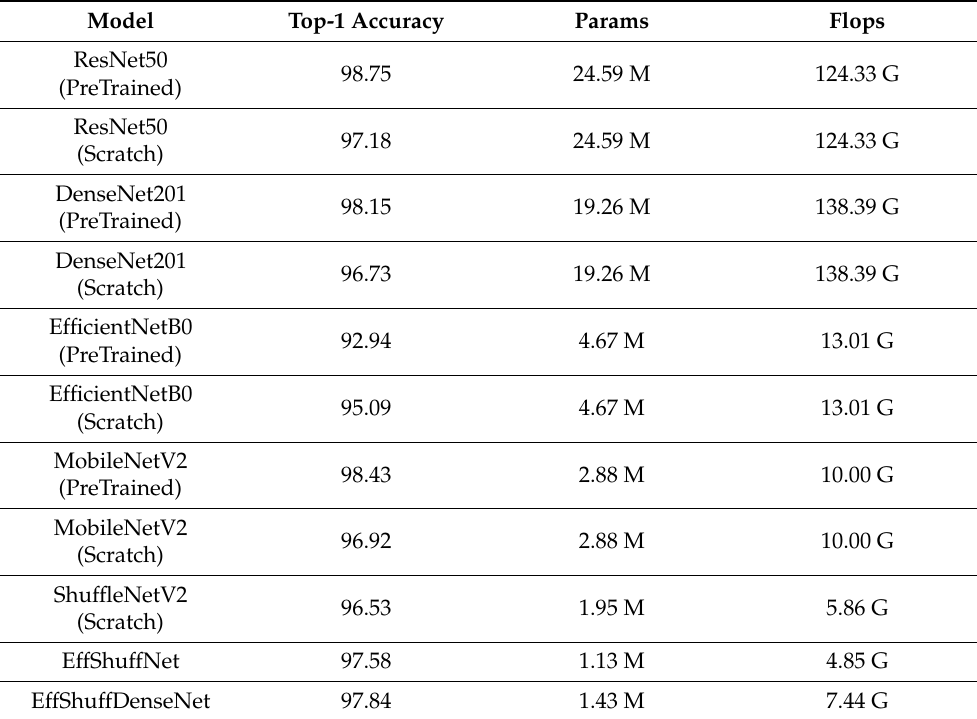
Table 4. Experimental results of gender